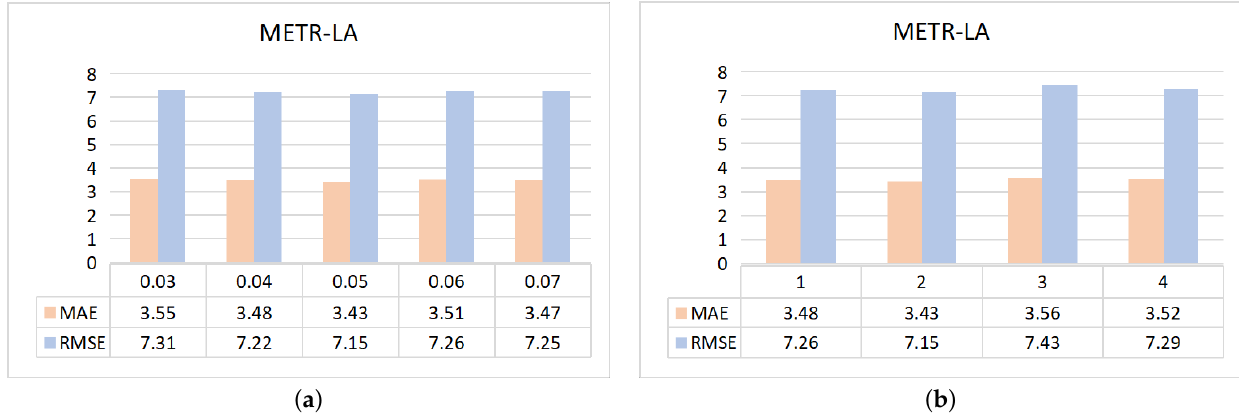
Figure 7. Study of model parameters on METR-LA; ( a ) the error of the parameter λ at different values; ( b ) errors at different values of the number of layers of the spatial